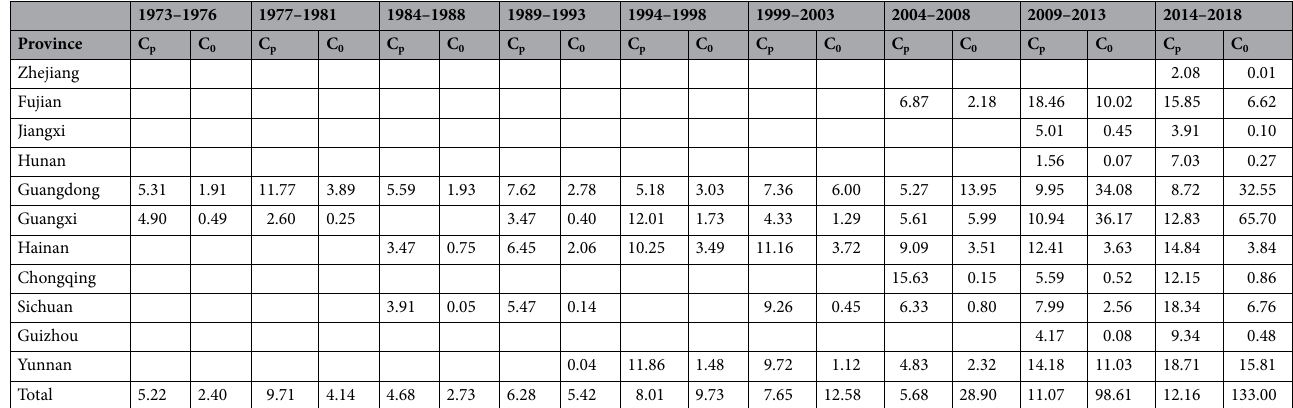
Table 13. Eucalyptus carbon density and storage by province. “Cp” and “C 0 ” refer to Forest biomass carbon density (unit: t 4 hm −2 ) and Biomass carbon stocks (unit: TgC),